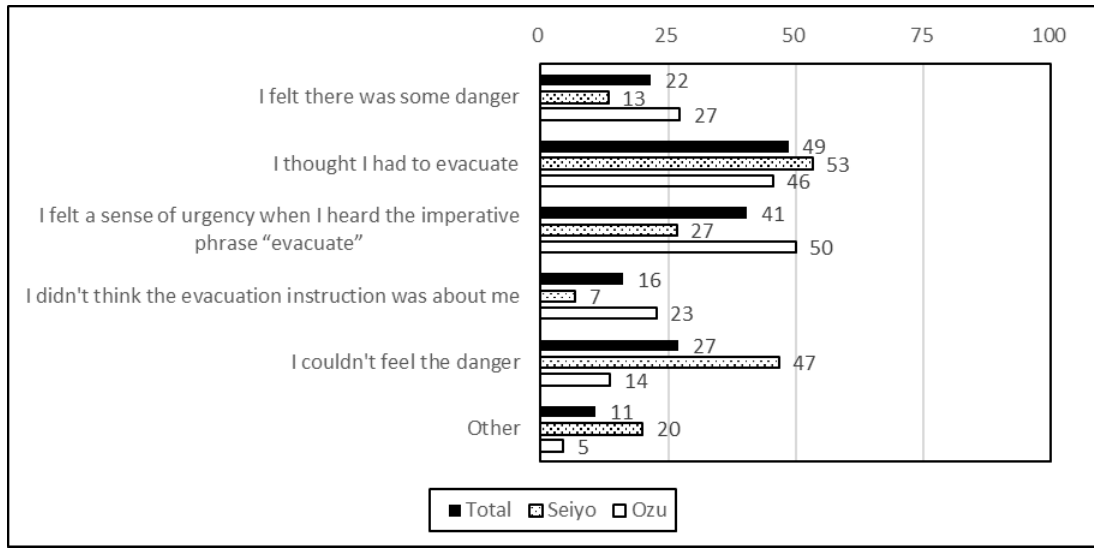
Figure 12. Feelings induced when residents heard the evacuation instructions (%), n = 37, (multiple answers).